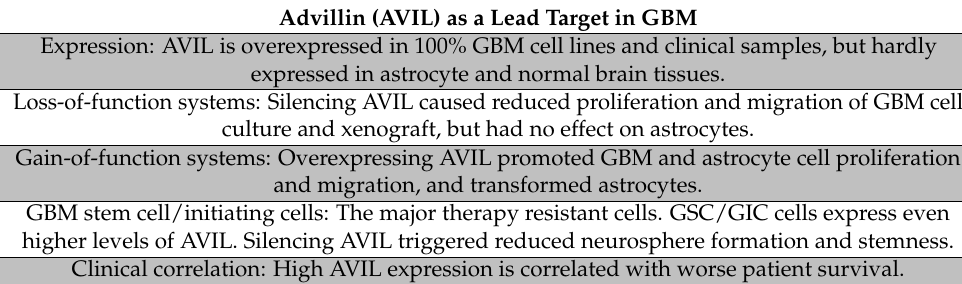
Table 1. Overview of AVIL as a lead target in